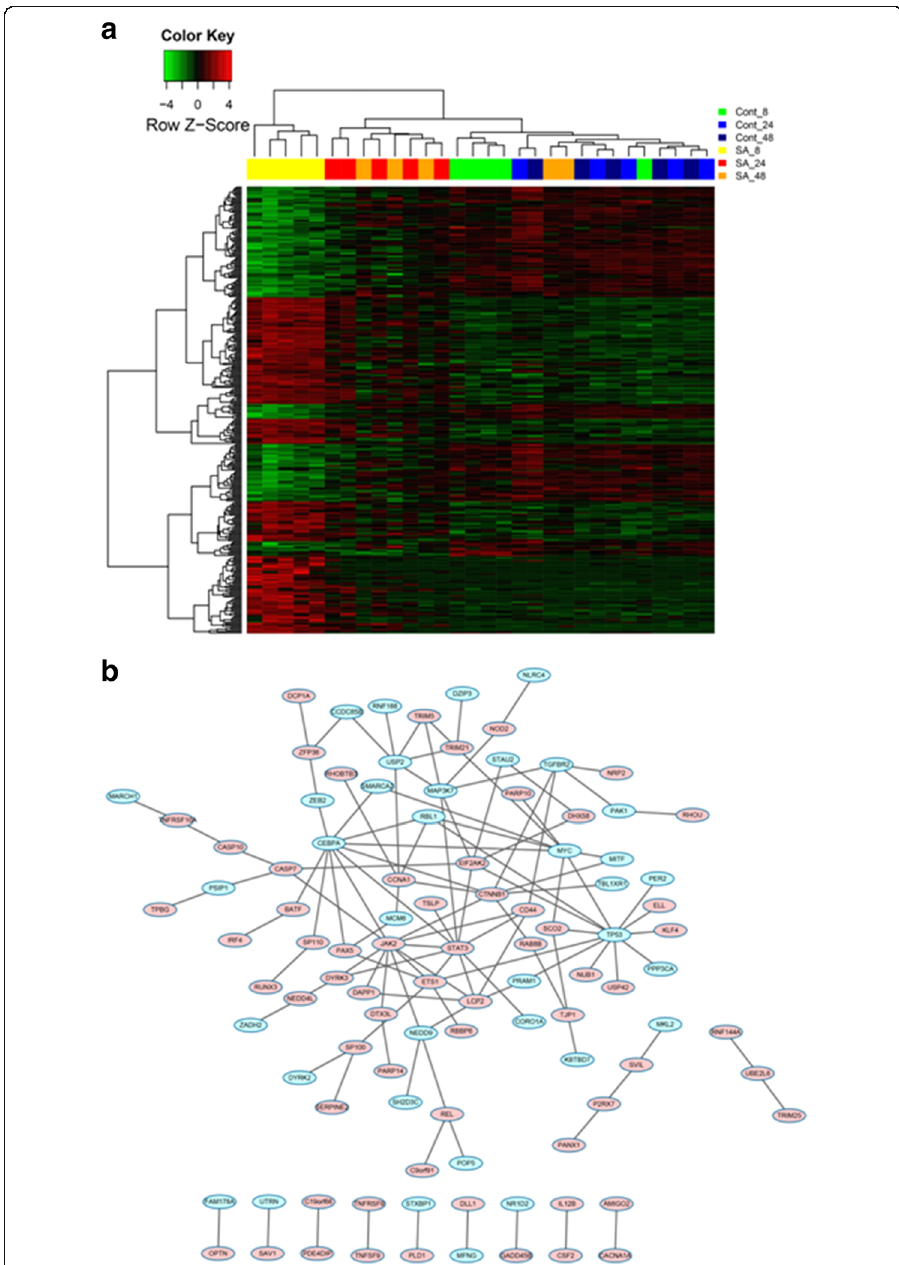
Fig. 3 Heat map of common DEGs in Comparison 1 ( a ) and corresponding biological network ( b ). a Heat map of hierarchical clustering for common DEGs in Comparison 1. “ Red ” : high expression, “ green ” : low expression. b Biological network constructed according to the direct connection among DEGs. “ Red ” : up-regulation, and “ green ” :